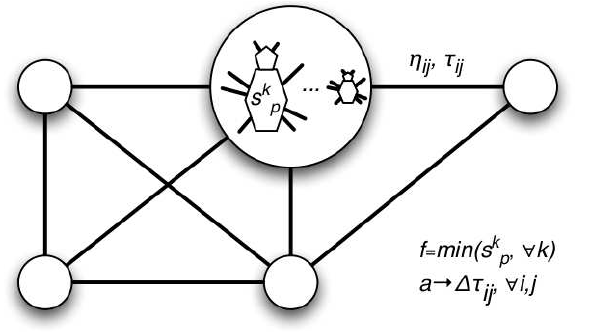
Figure 2. Schematic of an ACO instantiation of a CN. Nodes contain ants that construct paths s k p . Edges contain heuristic ij and pheromone η ij values. The function f is given by the best path found. Algorithm a adjusts pheromone concentrations τ ij